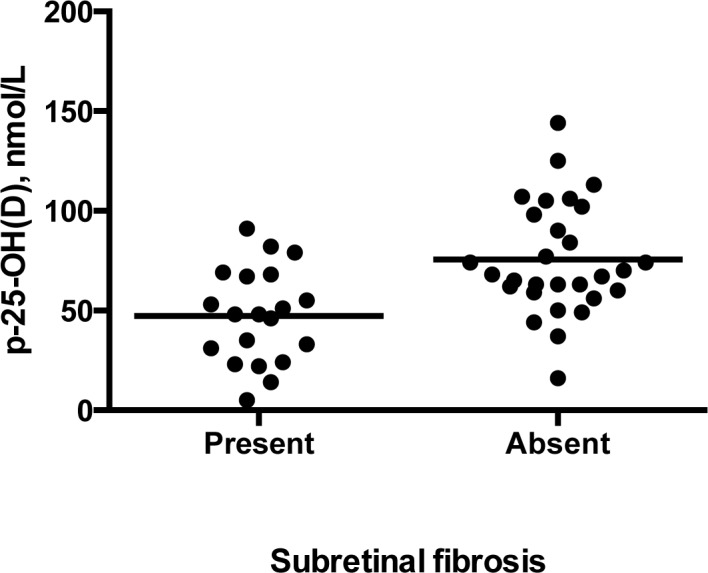
25-hydroxyvitamin D in patients in CARMS 5 with or without subretinal fibrosis.Patients with subretinal fibrosis had significantly lower plasma 25-hydroxyvitamin D concentrations compared to patients without subretinal fibrosis (p<0.001). Horizontal lines represent means.